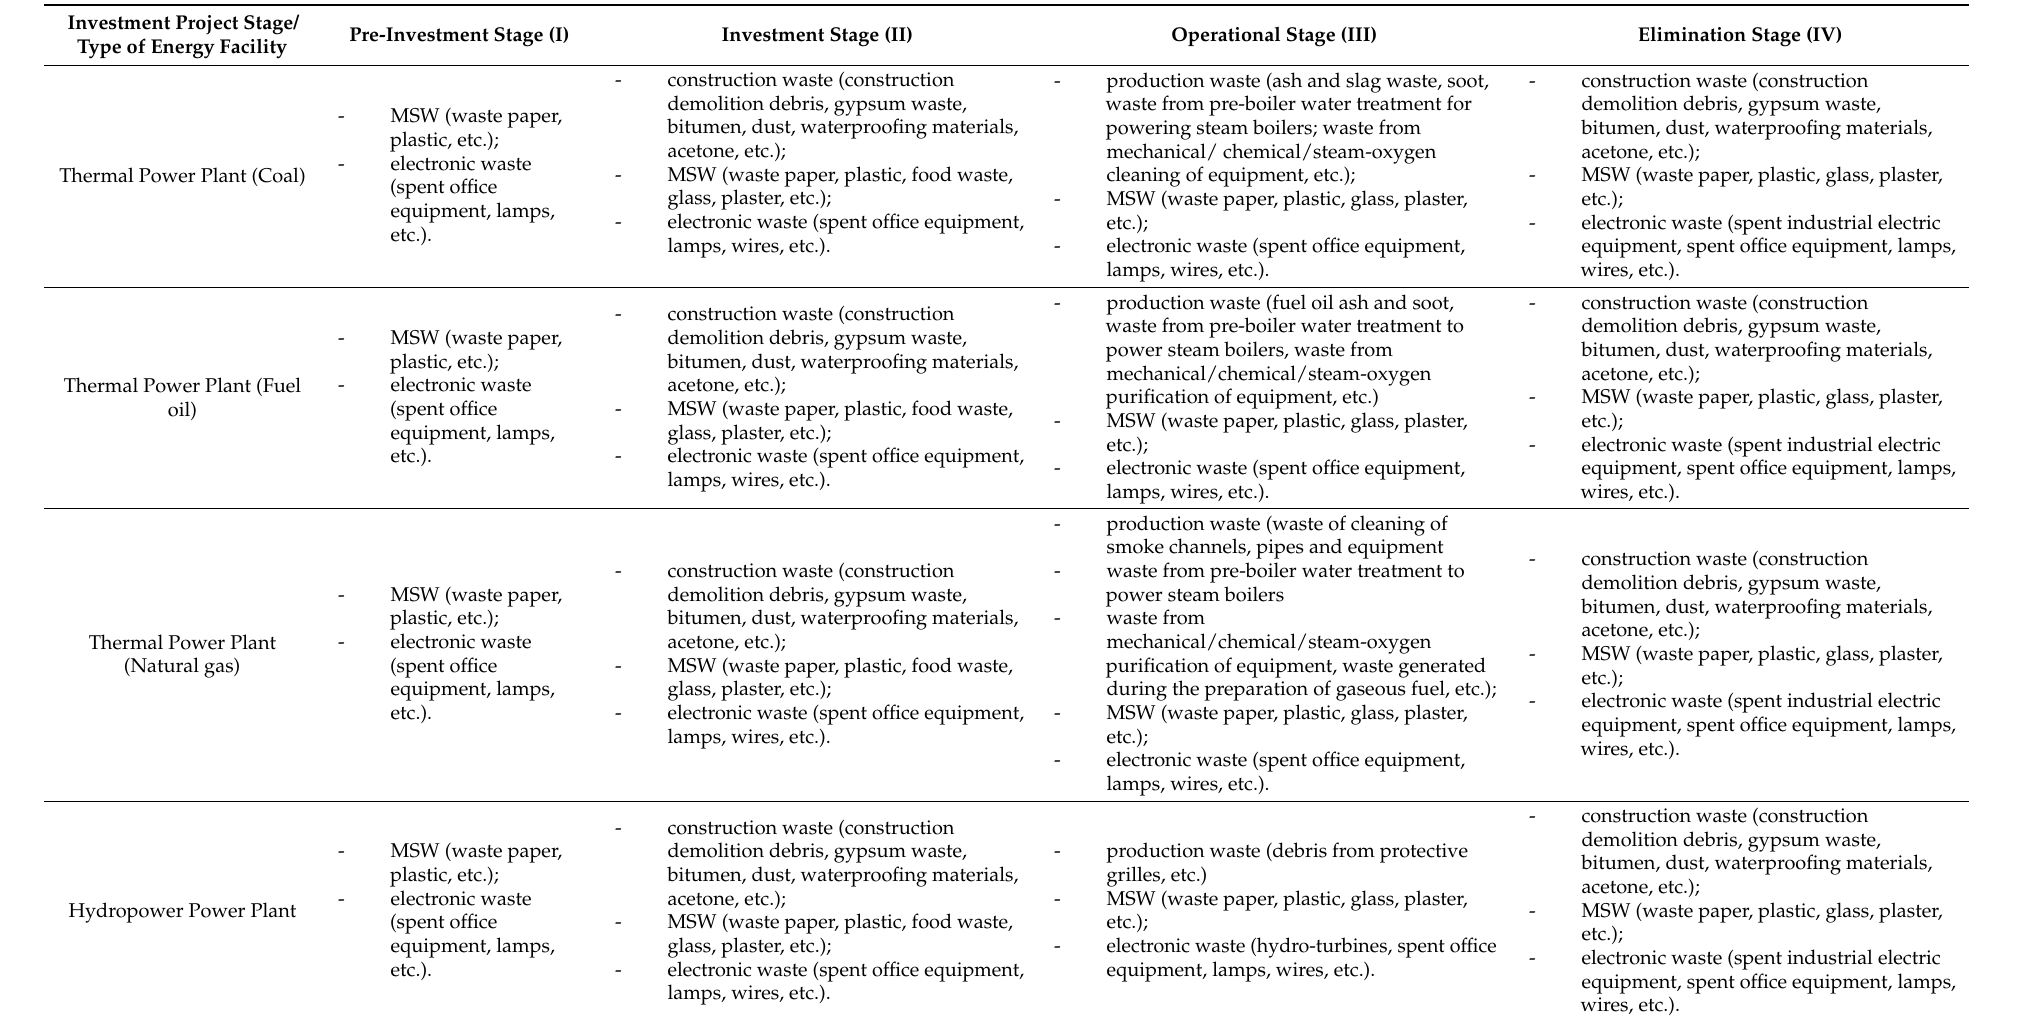
Table 4. Types of waste generated at various stages of the project life cycle in the energy sector (made by the